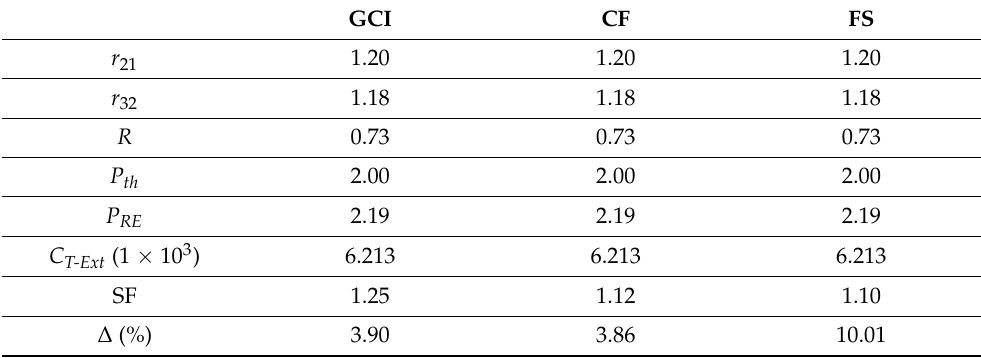
Table 4. Uncertainty assessment results.